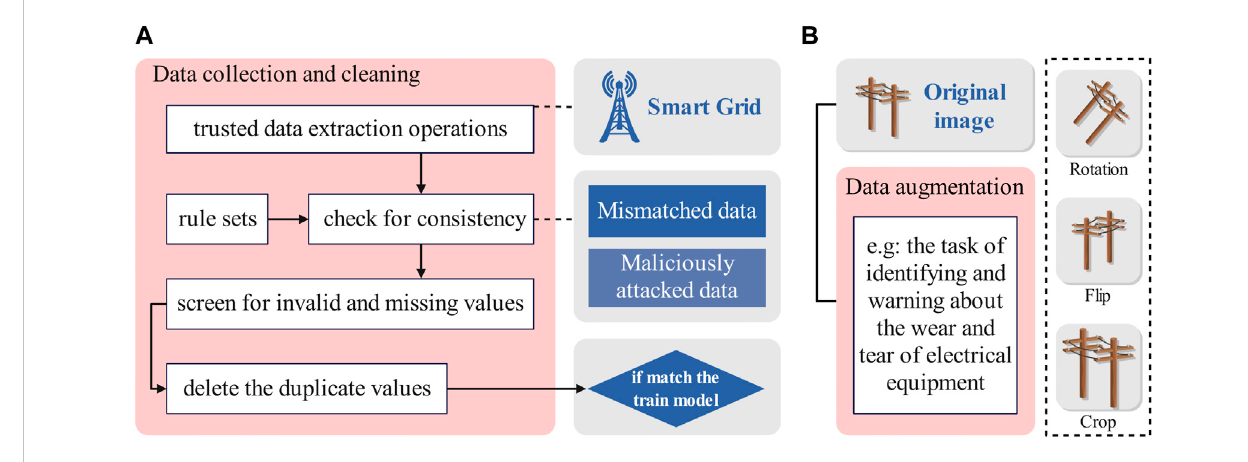
FIGURE 3 Pre-processing stage. (A) Data collection and data cleaning (B) Data